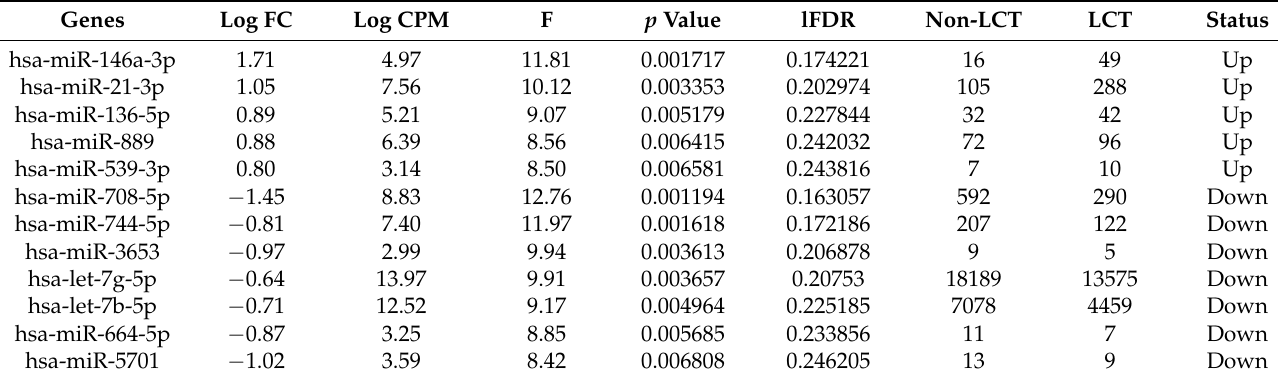
Table 2. Up- and downregulated miRNAs MF-LCT vs.